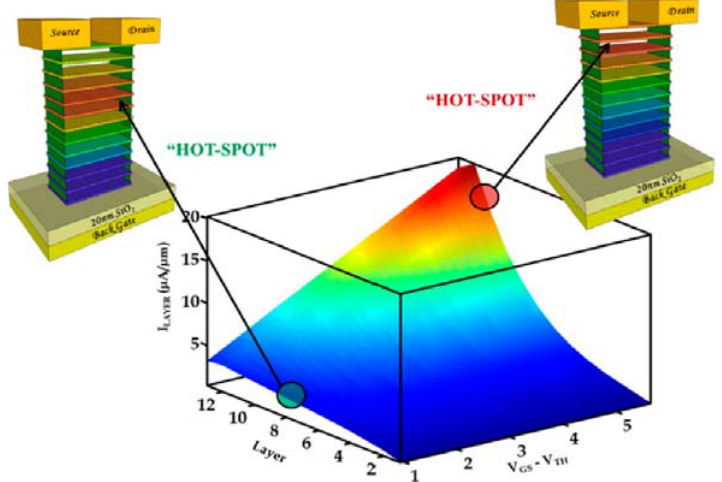
Figure 3. Current distribution among the individual layers of a 13 ‐ layer thick MoS 2 FET at different gate bias conditions derived using the resistor network model. The illustrations show the location of the “HOT ‐ SPOT” and the associated current spread schematically corresponding to two different gate bias conditions. The red and blue colors representing the highest and lowest current, respectively. Reproduced with permission from [89], American Chemical Society, 2013.